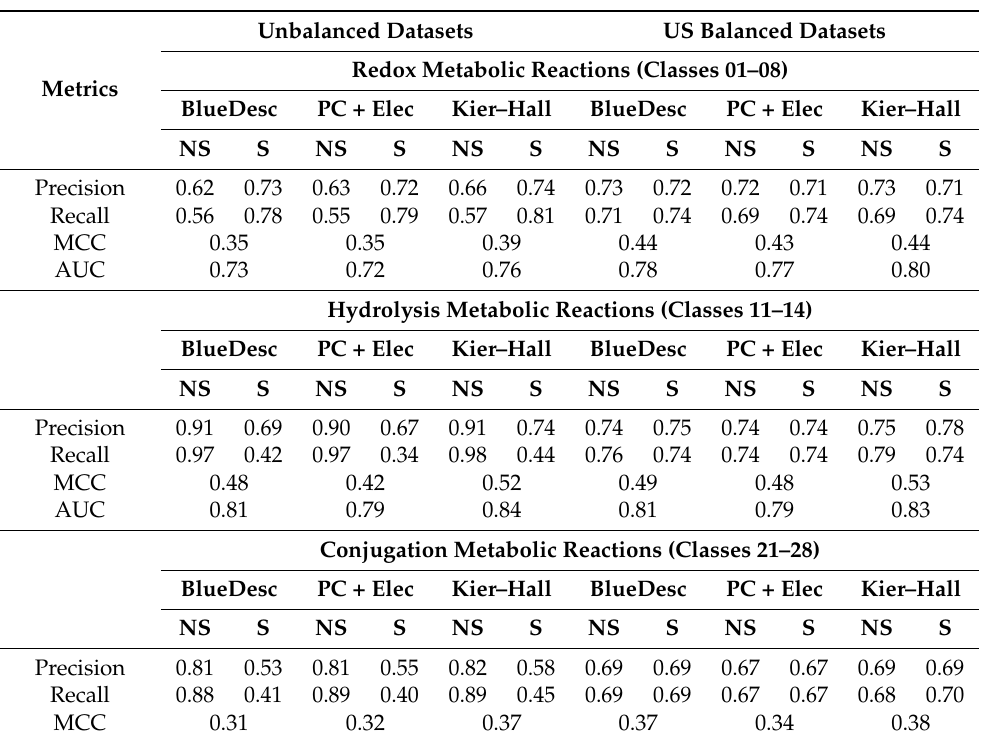
Table 1. Performance of the predictive models for the three major classes of metabolic reactions by considering both the unbalanced and the randomly undersampled (US) balanced datasets. Three sets of descriptors were used for each analysis (S and NS stand for substrates and non-substrates, respectively; PC + Elec indicates the set of physicochemical plus stereo-electronic